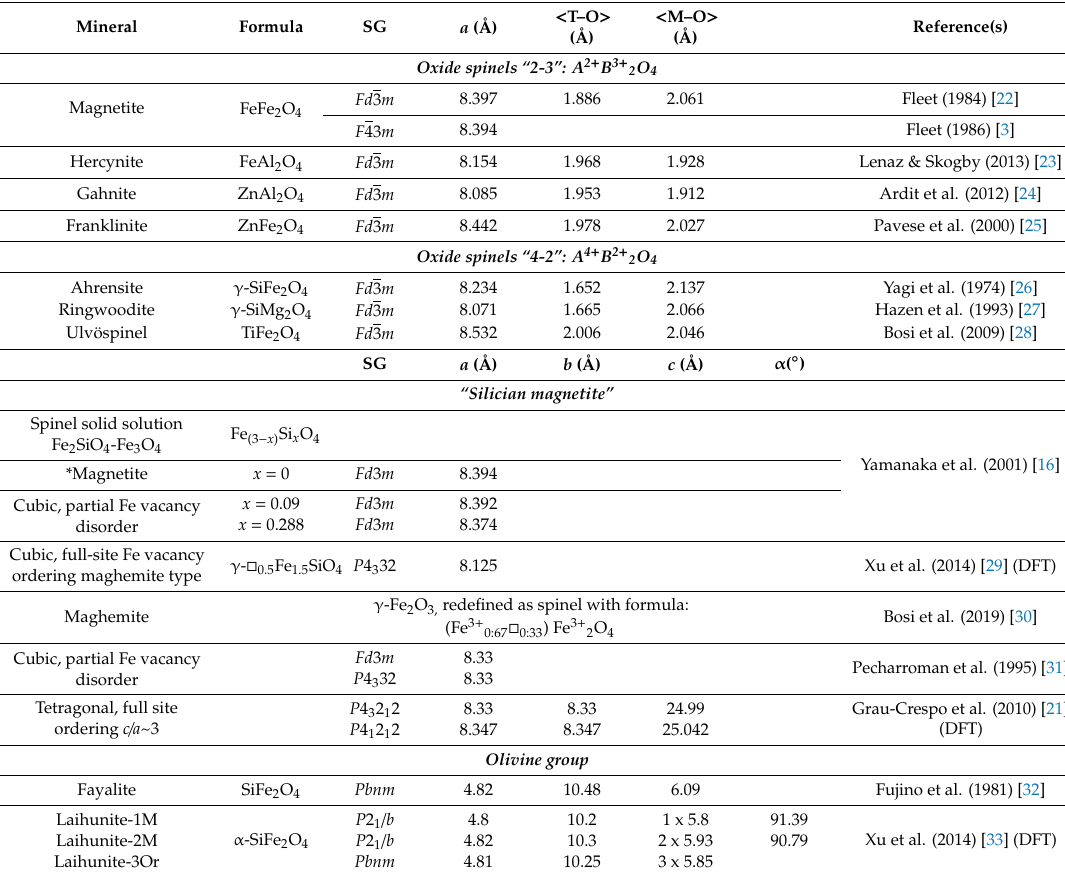
Table 1. Overview of minerals and phases